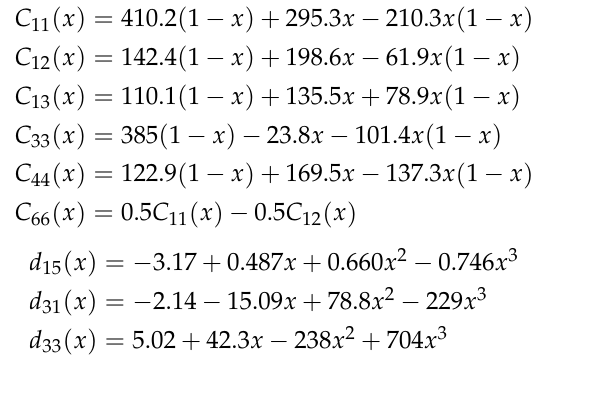
Table 3. Material properties used in the simulation of both devices A and B [4,8,16,23,39,40]. Parameter Si SiO 2 Pt Mo Au Young’s Modulus [GPa] 170 70 168 312 70 Poisson’s Ratio 0.28 0.17 0.38 0.31 0.44 Density [kg/m 3 ]